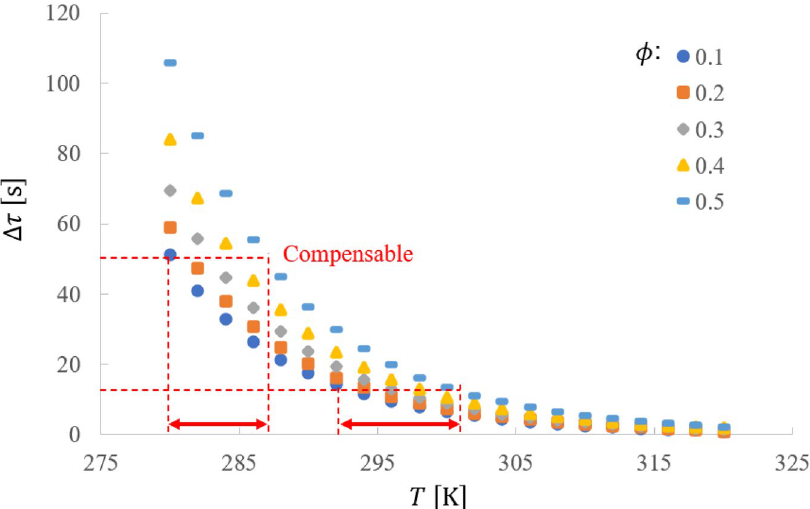
Figure 3. A theoretical estimation of the BZ gel’s oscillation period �τ with varying temperature T and volume fraction φ , which is given by Eq. (16). Here, rate constants and activation energies at T = T 0 = 298[K] are set as k ∗ = 1